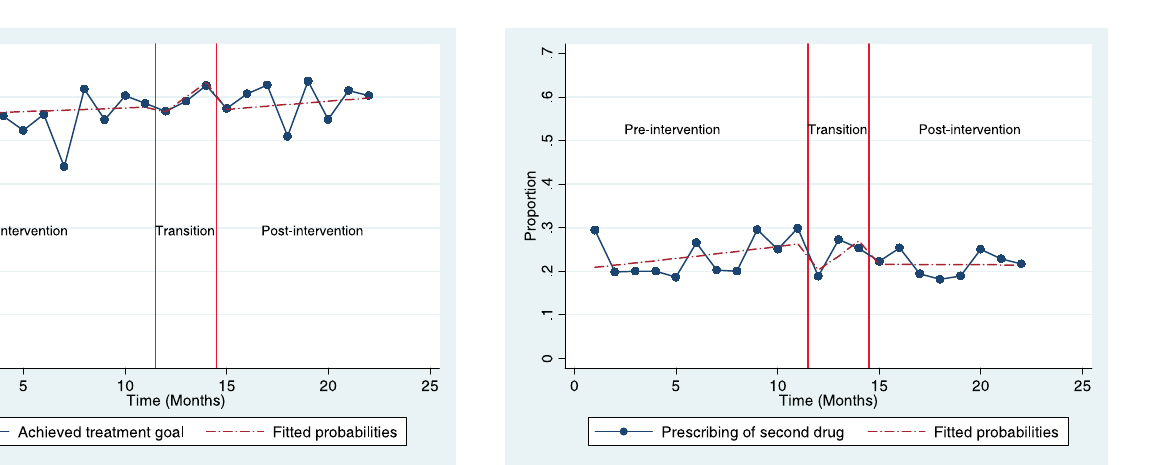
Figure 3. Proportion of Patients Achieving Treatment Goals ( (cid:4) 140/90 mm Hg) within 4 mo, among All Started on Treatment for Uncomplicated Hypertension